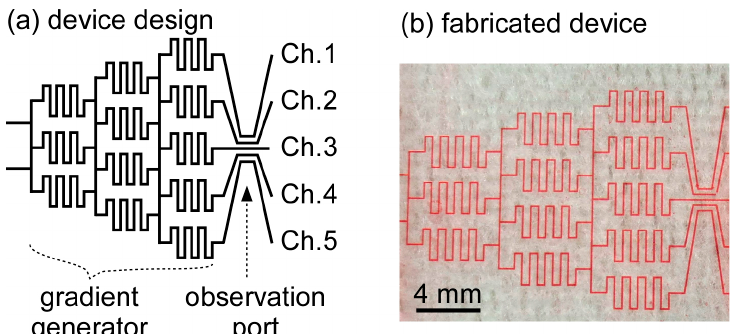
Figure 2. Fabrication of the microfluidic device. ( a ) Wafer cleaning with acetone and ethanol in an ultrasonic bath; ( b ) SU-8 patterning for the mold of the microchannels; ( c ) SU-8 patterning for the mold of the microchamber; ( d ) Polydimethylsiloxane (PDMS) curing; ( e ) Peeling off the PDMS replica from the mold; ( f ) Bonding the PDMS replica and a glass substrate.